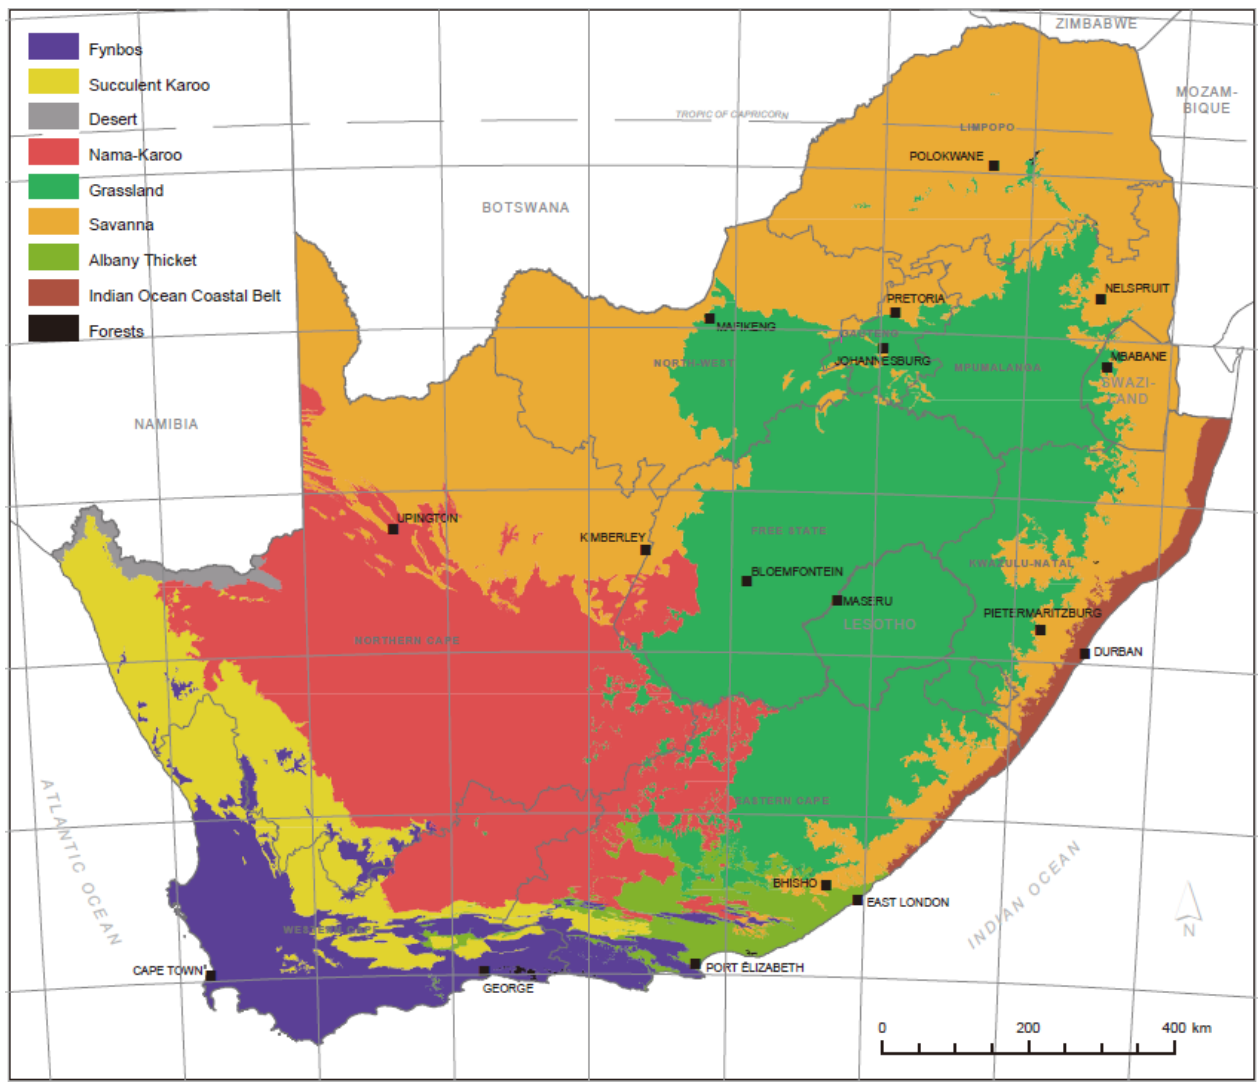
Figure 1. Map of nine biomes in South Africa: Fynbos, Succulent Karoo, Desert, Nama-Karoo, Grassland, Savanna, Albany Thicket, Indian Ocean Coastal Belt, and Forests [24].